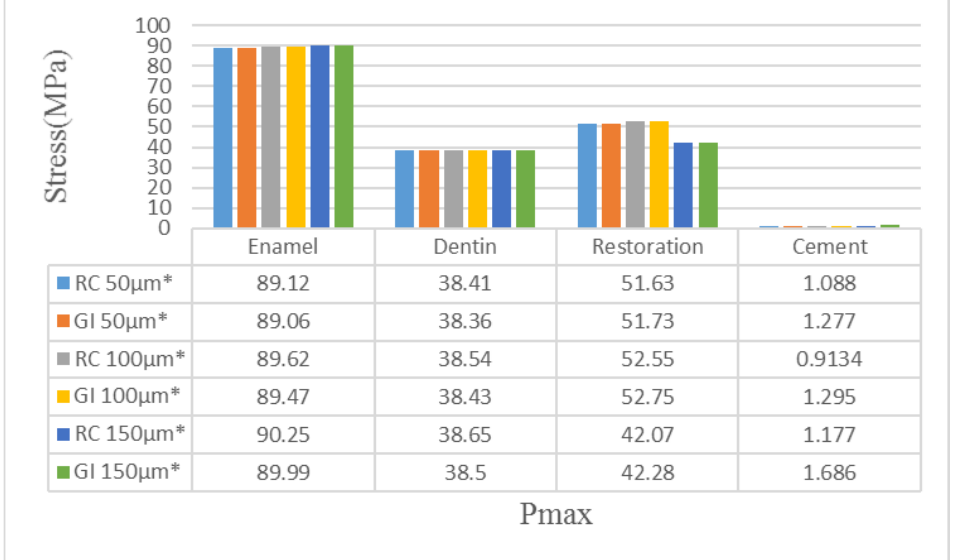
Figure 11. Maximum principal stress distribution in restorations with cements of different thickness (* 35 GPa Young’s modulus of amalgam).